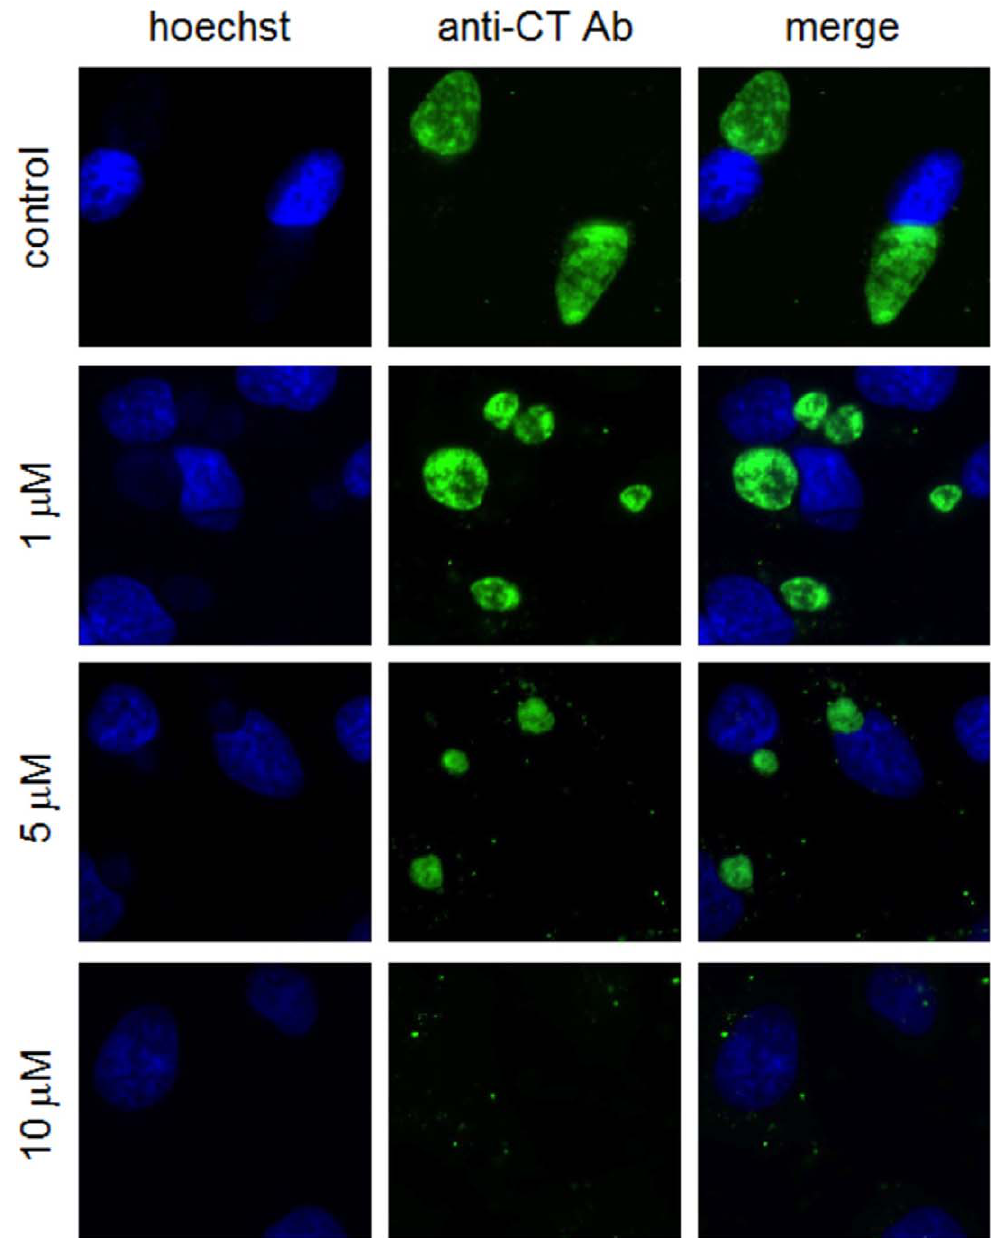
Figure 2. Ivermectin inhibits the development of chlamydial inclusions in epithelial cells. HeLa cells grown on glass coverslips were infected with C. trachomatis serovar L2 at an MOI of 1, followed by treatment with ivermectin at the indicated concentrations at 1 hour post infection (hpi). At 24 hpi, cells were fixed with ice cold methanol for 10 minutes, followed by staining with C. trachomatis genus antibodies (Argene) and Hoechst (Sigma), and observed on a widefield fluorescence microscope (Leica).